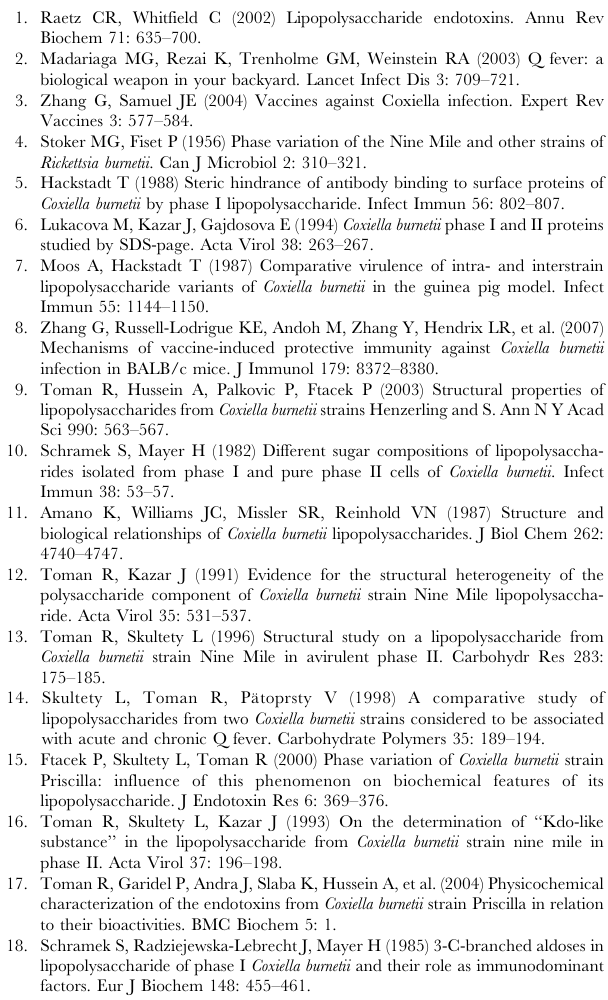
Figure S1 Clustal analysis of C. burnetii fucose synthase CBU0688 (GFS). The C. burnetii GFS has the characteristic